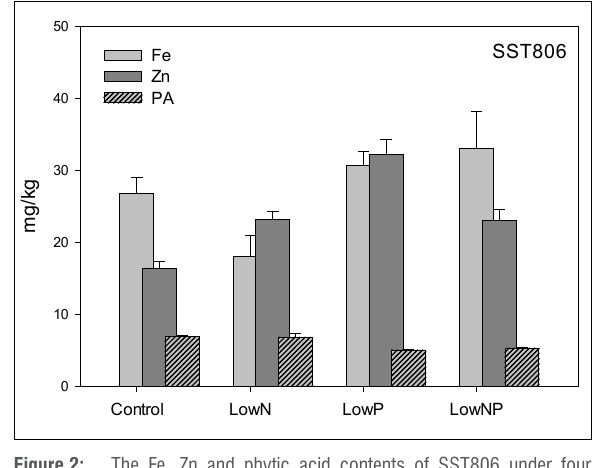
Figure 2: The Fe, Zn and phytic acid contents of SST806 under four treatments over two years. Values are means ± s.d. ( n =6). Analysis of variance for morphological traits in a trial of two wheat cultivars with four treatments over two years Cultivar